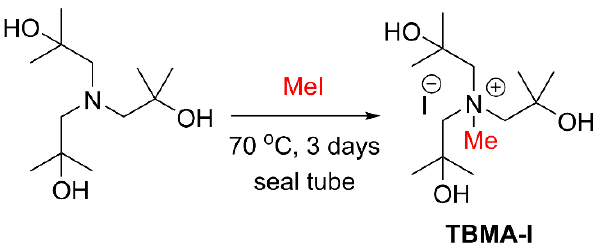
Scheme 1. Preparation of tri-( tert -butanol)-methylammonium iodide (TBMA-I) from tri-( tert